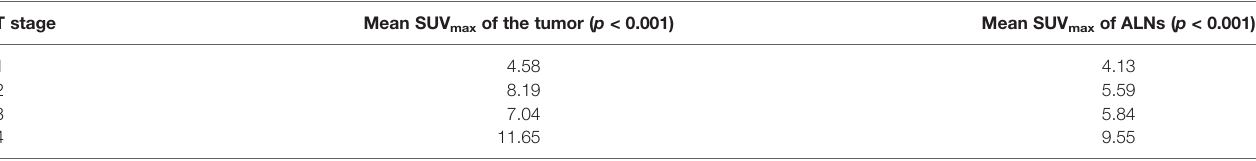
TABLE 5 | Relationship between T stage and the mean SUV max of tumor and ALN ( N = 268). T stage Mean SUV max of the tumor ( p < 0.001)